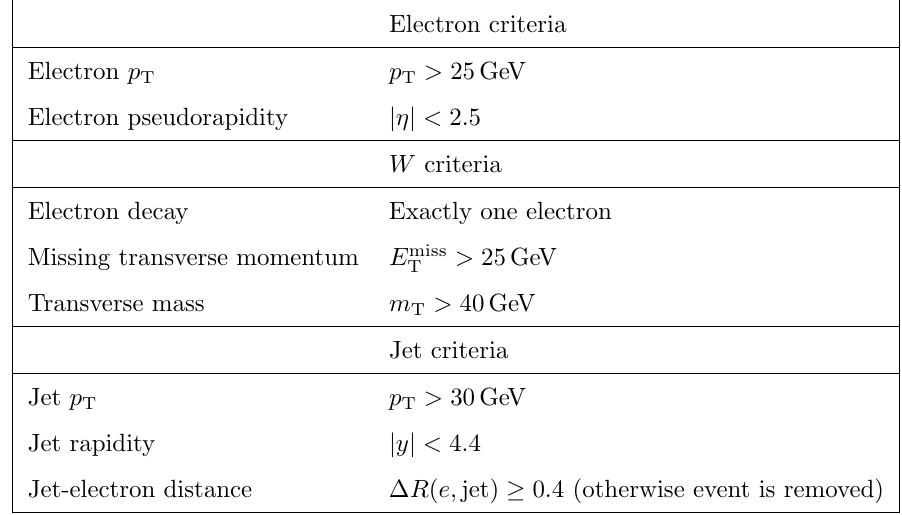
Table 2 . Kinematic criteria de(cid:12)ning the (cid:12)ducial phase space for the W ! e(cid:23) (cid:12)nal state in association with